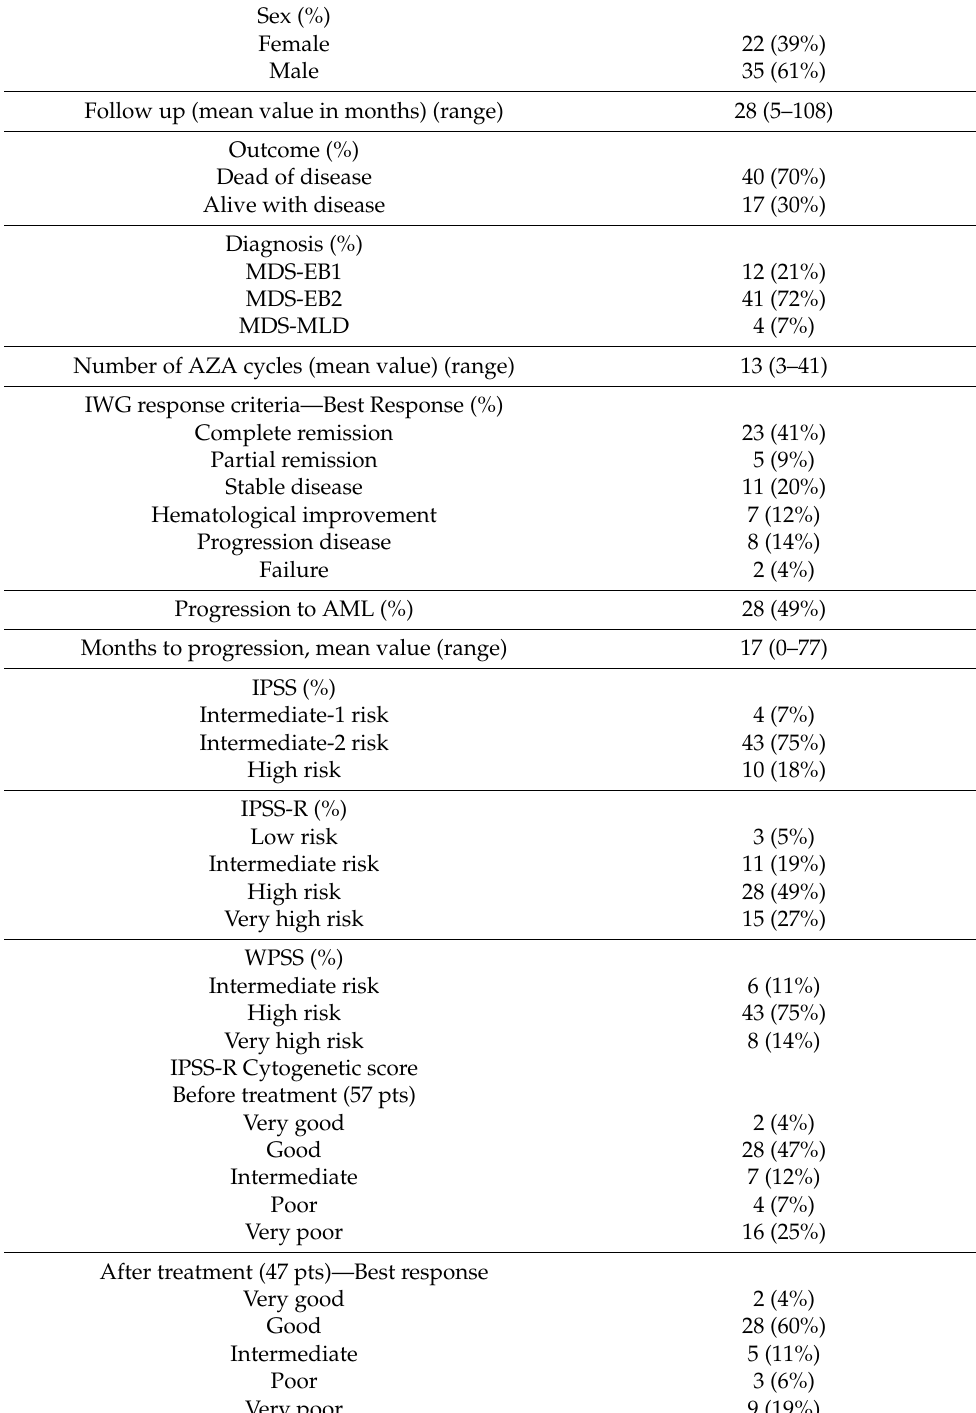
Table 1. Clinical and prognostic features of the